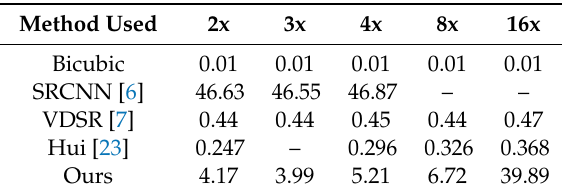
Table 5. Computation time